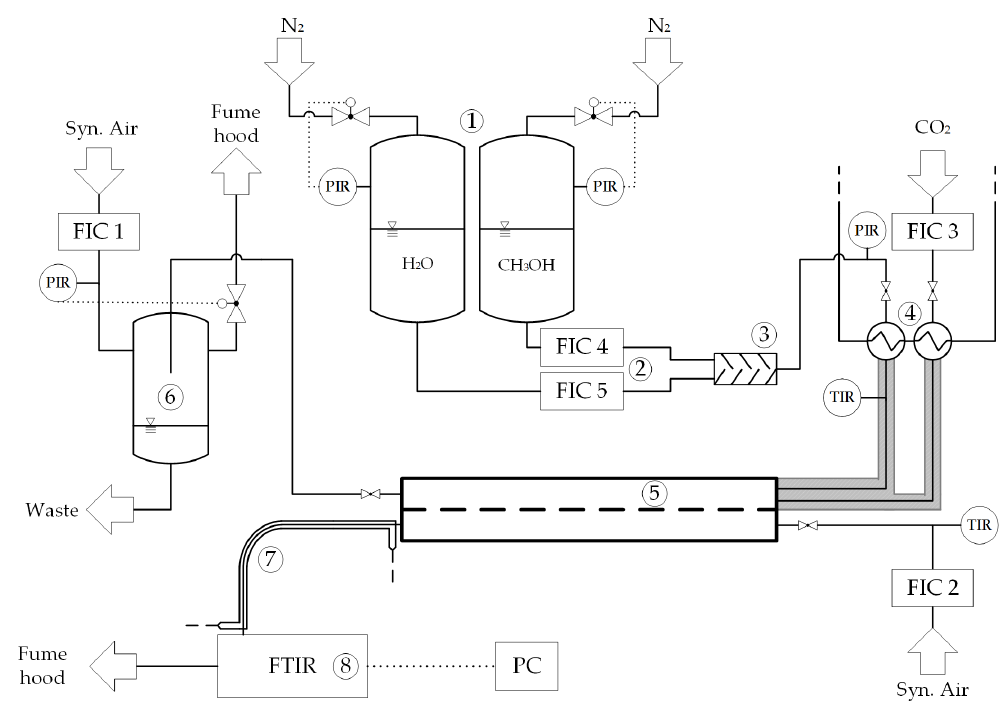
Figure 6. Scheme of the experimental setup.